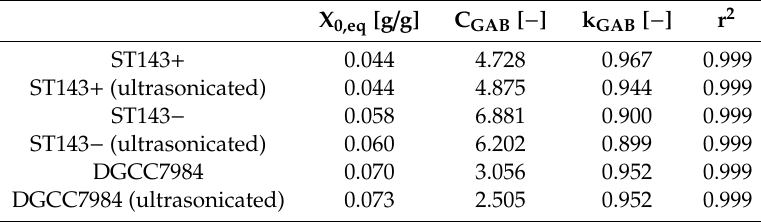
Table 1. Coe ffi cients of the Guggenheim–Anderson–De Boer (GAB) adsorption isotherms X 0,eq , C GAB , and k GAB for S. thermophilus ST143 + , ST143 − , and DGCC7984 cells without and with ultrasonic treatment for CPS